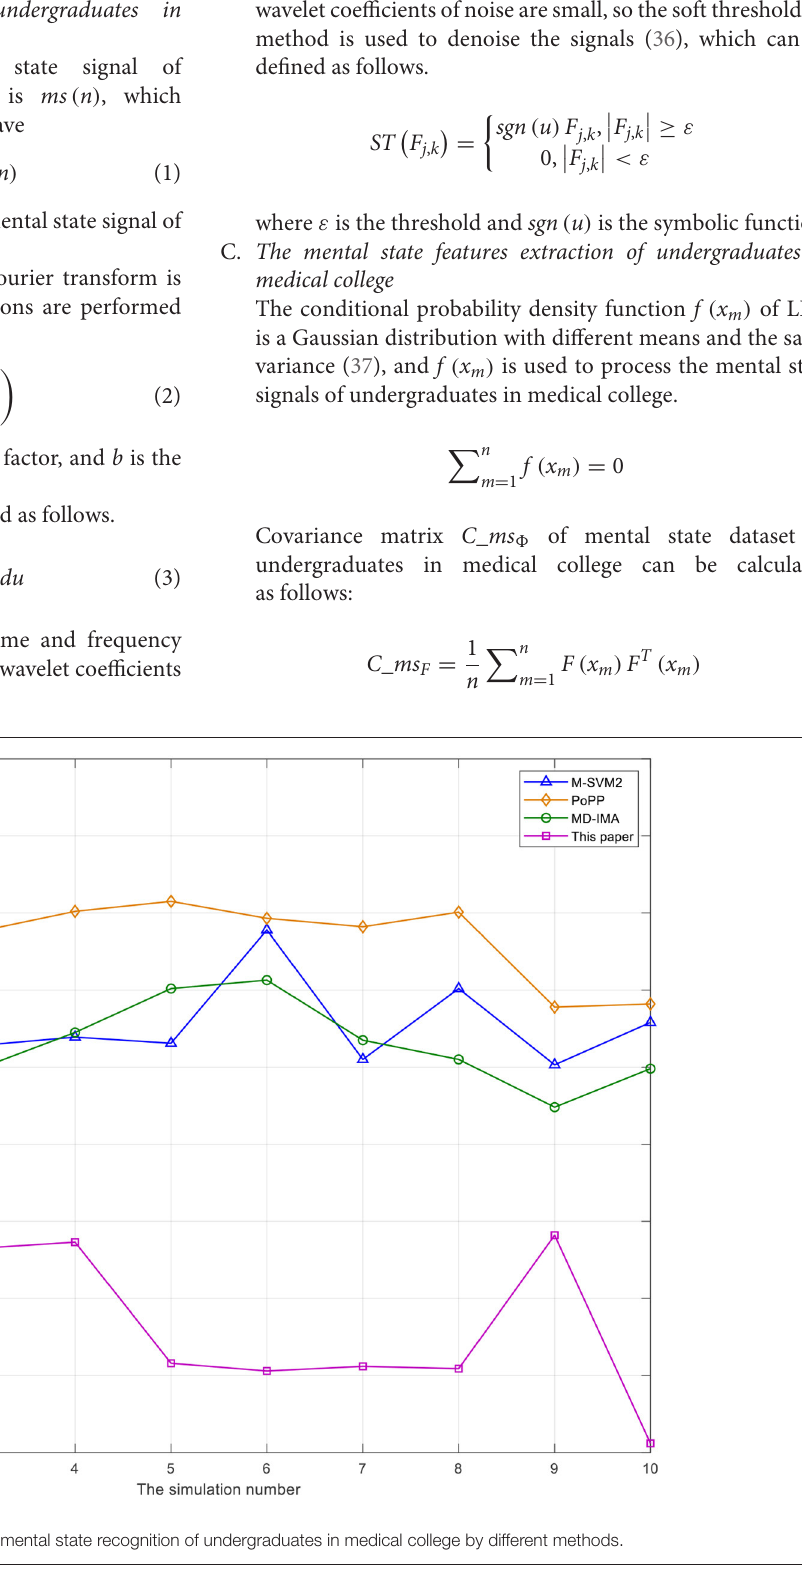
Frontiers in Public Health |